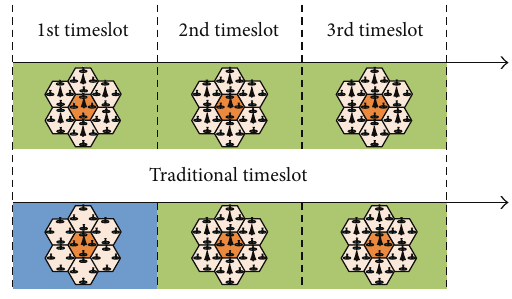
Figure2:Illustrationofdifferencesbetweentraditionaltimeslotand timeslot with compensation timeslot